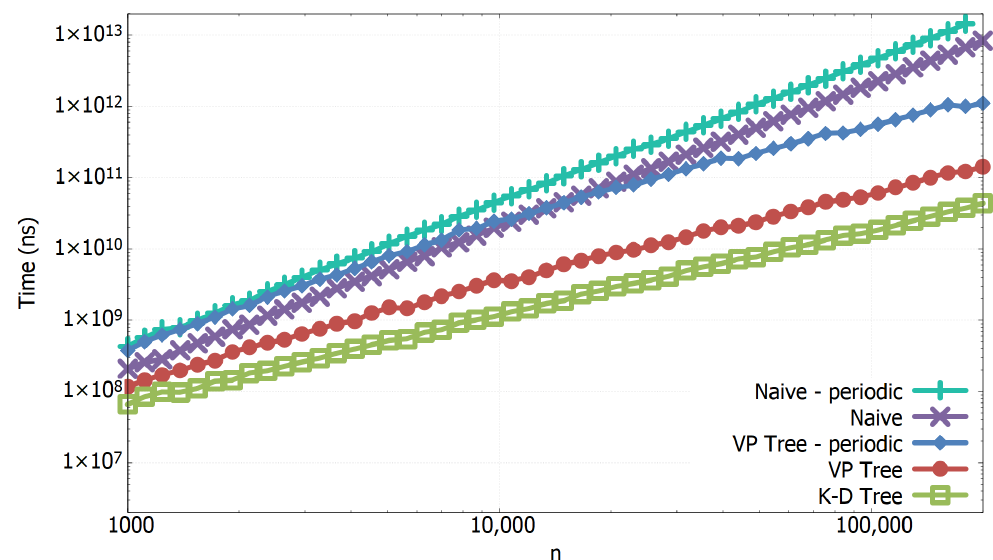
Figure 1. Computational times comparison of the all- k -nn algorithms as the number of points n grows. d = 6, k = 20, 1000 ≤ n ≤ 200,000. Double logarithmic scale.